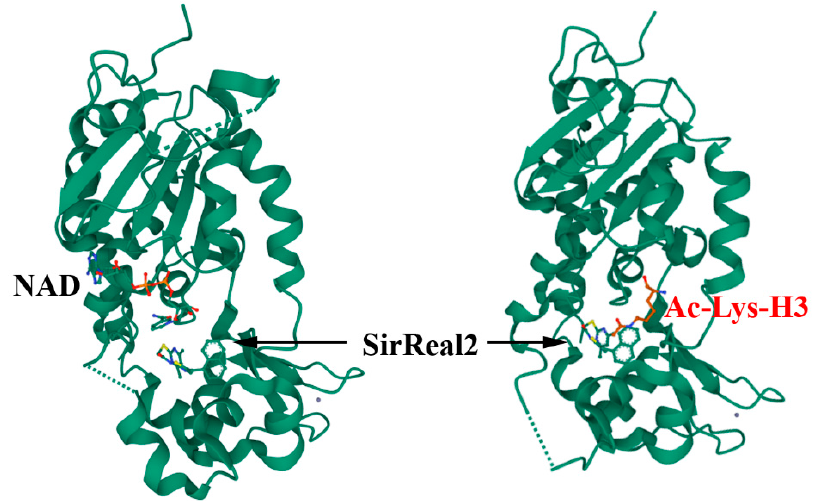
Figure 3. Allosteric regulation: SirReal2 selectively inhibits Sirt2 and functions as a molecular wedge